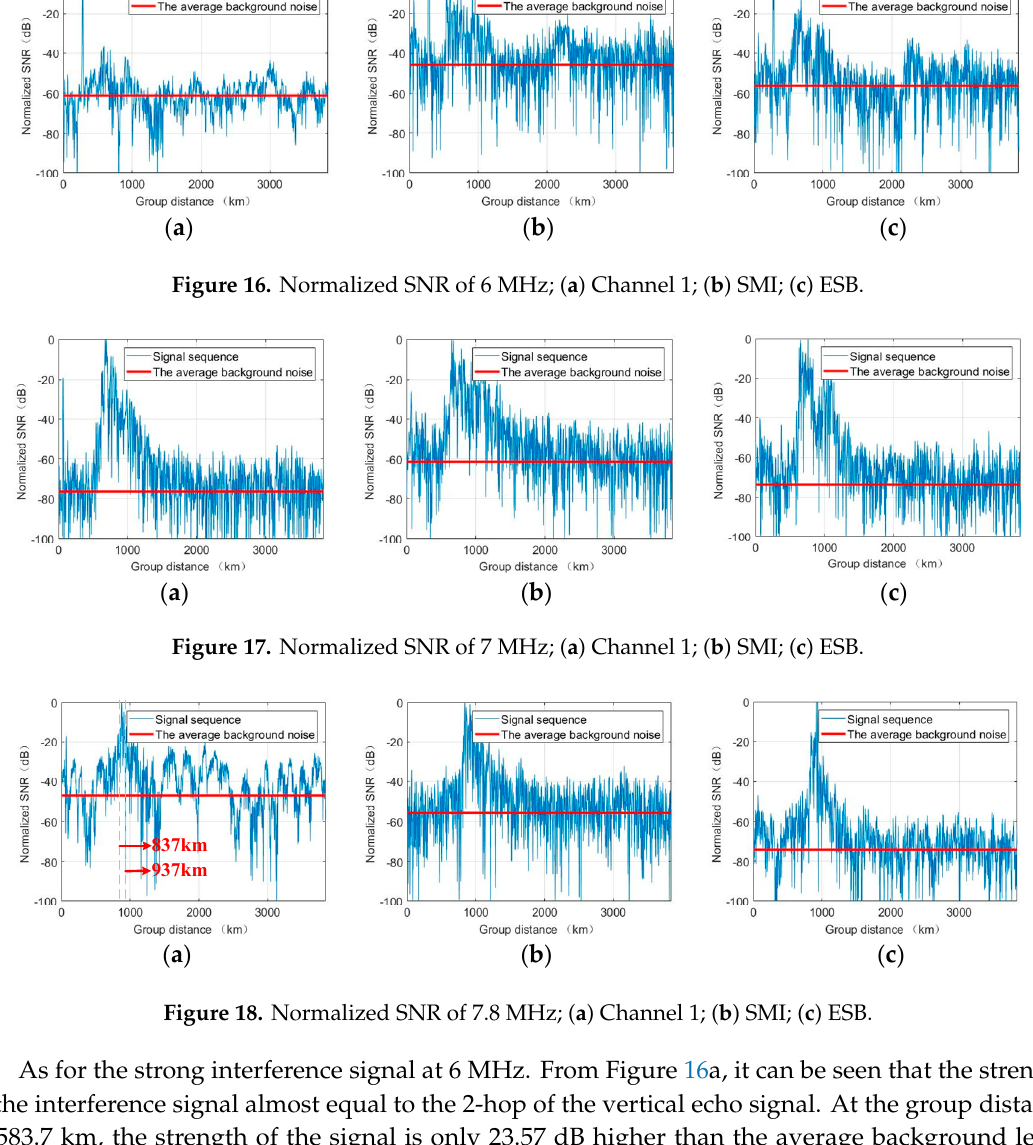
Figure 18. Normalized SNR of 7.8 MHz; ( a ) Channel 1; ( b ) SMI; ( c ) ESB.